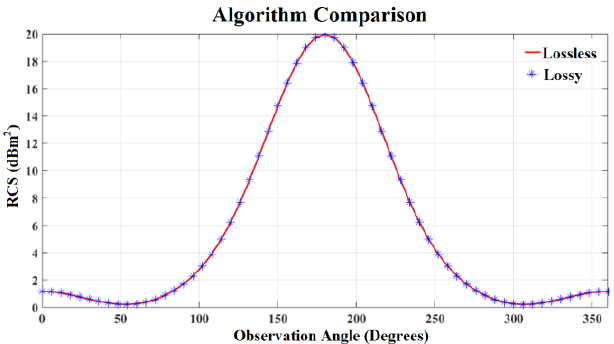
Figure 4: Comparison of SFIE algorithm for lossless and lossy cases with 𝜎 = 0 .